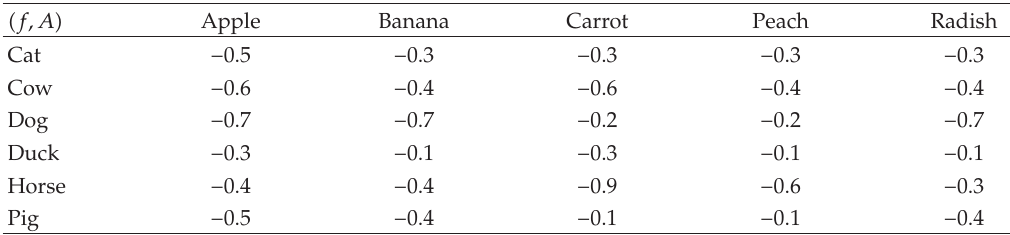
Table 1: Tabular representation of (cid:2) f,A (cid:3)